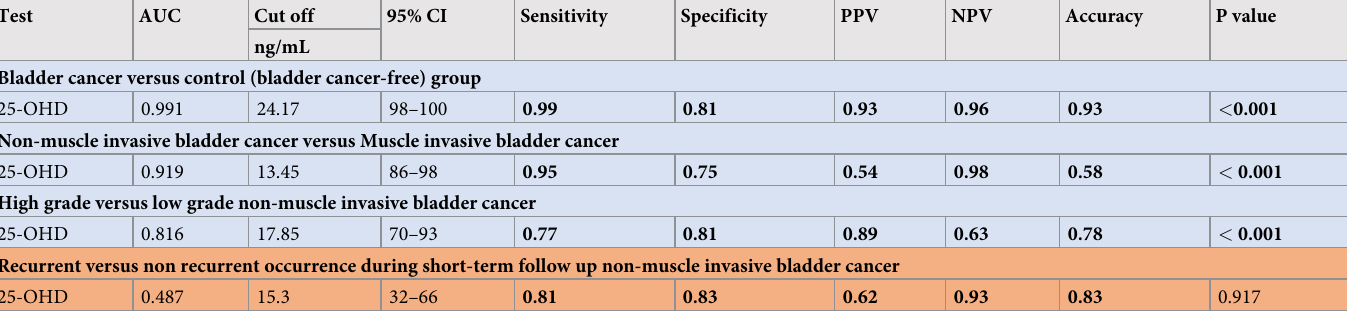
Table 2. Clinical performance characteristics of serum 25-hydroxyvitamin D in patients with hematuria for diagnosis, staging, grading of bladder cancer and prog- nosis of non-muscle invasive bladder cancer.